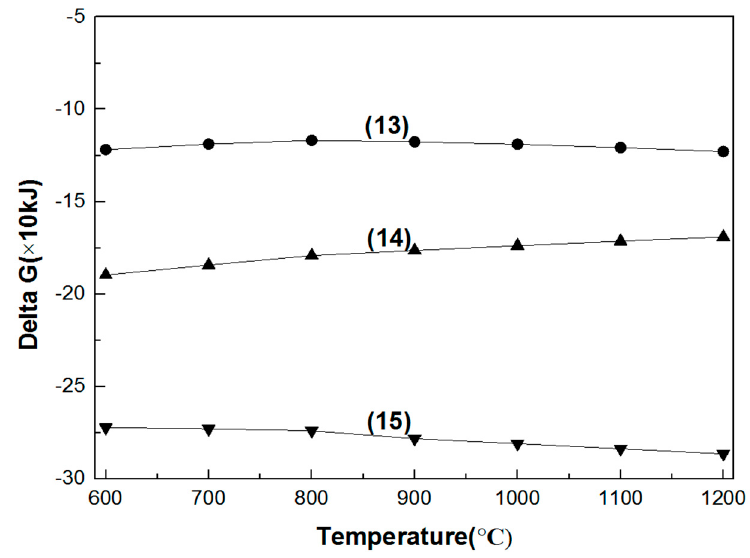
Figure 8. Gibbs free energy of the reactions between Na 2 CO 3 and intermediate products in the 600–1200 ◦ C temperature range. (13) Na 2 O · Fe 2 O 3 + 1/2MgO · Cr 2 O 3 + 3/4O 2 = 1/2MgO + Na 2 CrO 4 + Fe 2 O 3 ; (14) Na 2 O · Cr 2 O 3 + 3/4O 2 = Na 2 CrO 4 + 1/2Cr 2 O 3 ; (15) Na 2 CO 3 + Na 2 O · Cr 2 O 3 + 3/2O 2 = 2Na 2 CrO 4 + CO 2